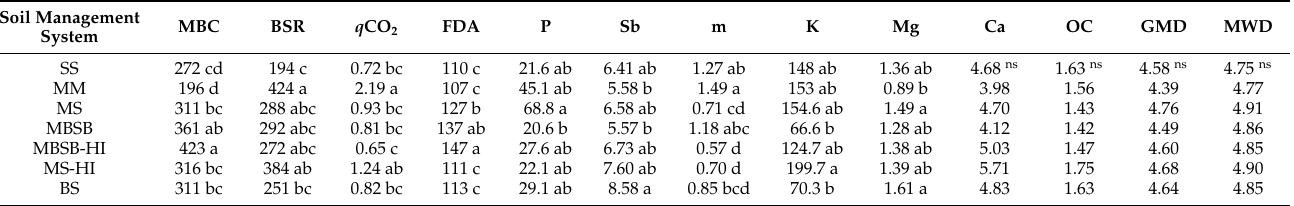
Table 2. Physical, chemical, and microbiological indicators evaluated in crop rows for each